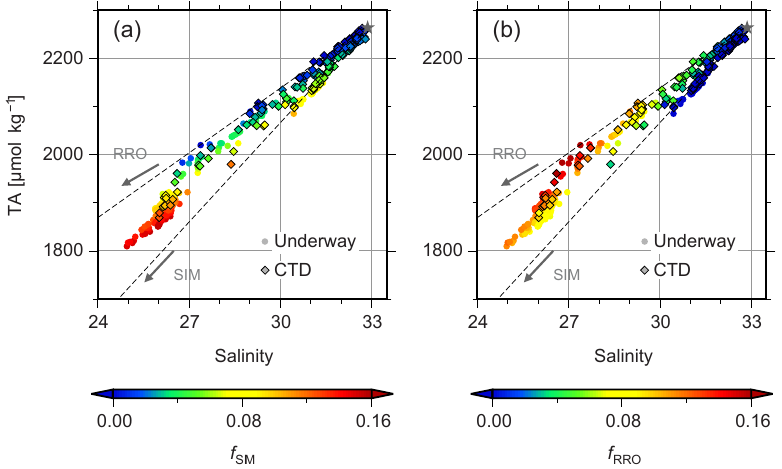
Figure 2. TA versus salinity in the western Arctic Ocean above the temperature minimum layer from 4 to 11 September 2013 color-coded for (a) the fraction of sea-ice melt ( f SIM ) and (b) the fraction of riverine outflow ( f RRO ) . Circles and diamonds denote surface water and CTD samples, respectively. Star denotes the salinity and TA of Pacific-origin water (POW: S = 32.89 and TA = 2264.2µmolkg − 1 ) . Broken lines extend to the two endmembers, sea-ice melt (SIM: S = 5 and TA = 349µmolkg − 1 ) and riverine output (RRO: S = 0 and TA = 793µmolkg − 1 )